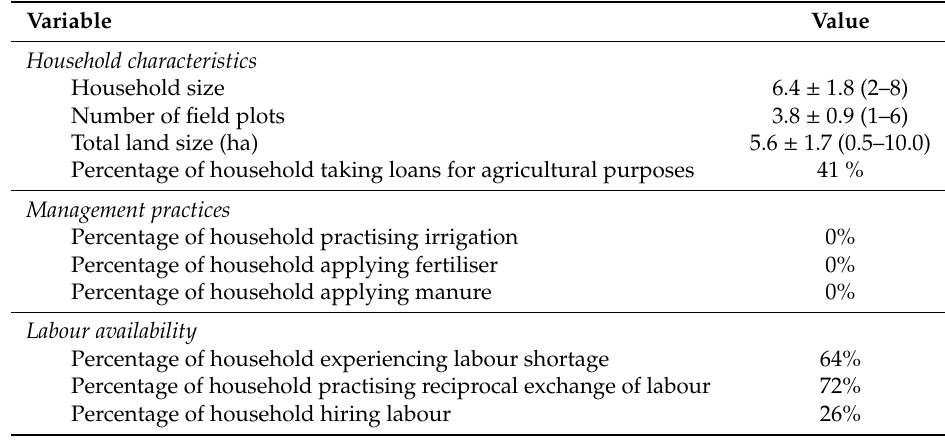
Table 2. Household characteristics, management practices and labour availability of the studied villages.